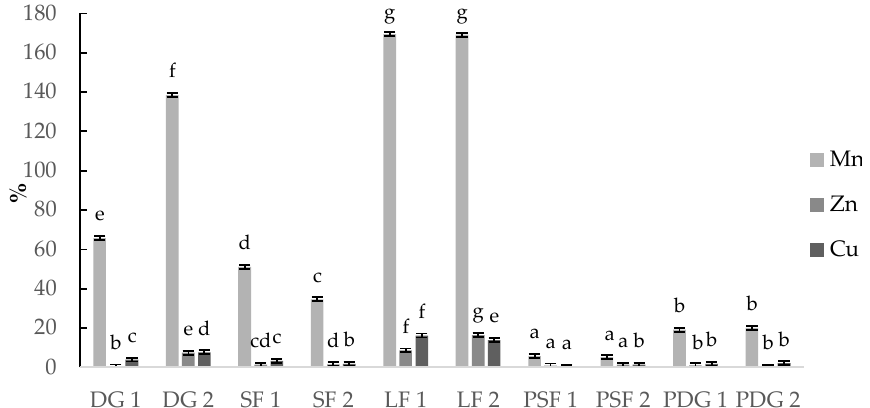
Figure 4. Apparent heavy metals recovery (A HMs R) from different forms of digestate. The standard deviation within each treatment ( n = 3) is indicated by the line extending the column. Values followed by the same letters in the column (separately for HMs) are not statistically different ( p < 0.05).